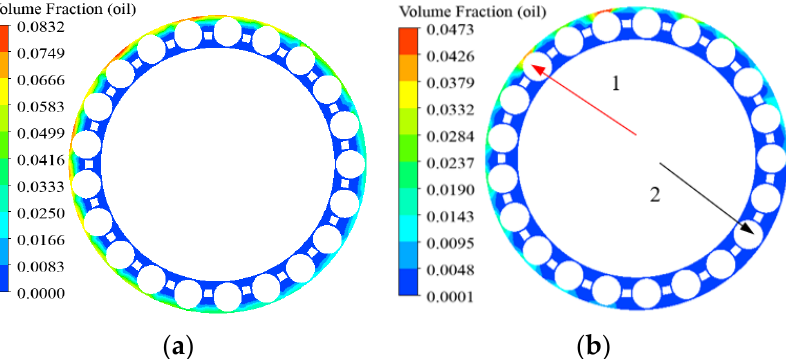
Figure 15. Lubricating oil distributions at the center sections of the bearing small rollers. ( a ) Outer ring rib structure; ( b ) Inner ring rib structure.